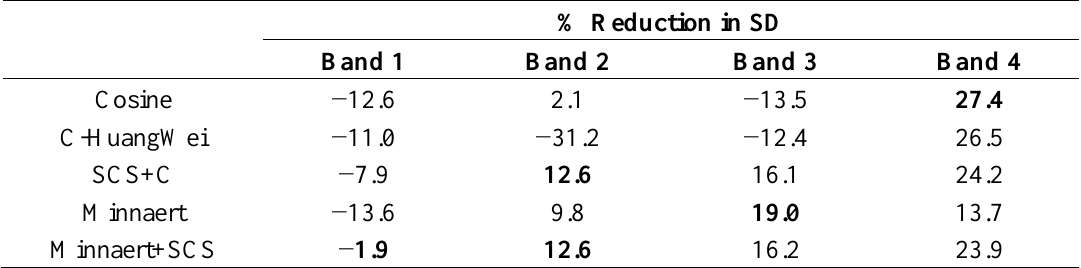
Table 5. Mean reduction (%) of standard deviation (SD) compared with the original image for vegetation pixels after topographic correction. For each band, results of the best performing algorithm are presented in bold.